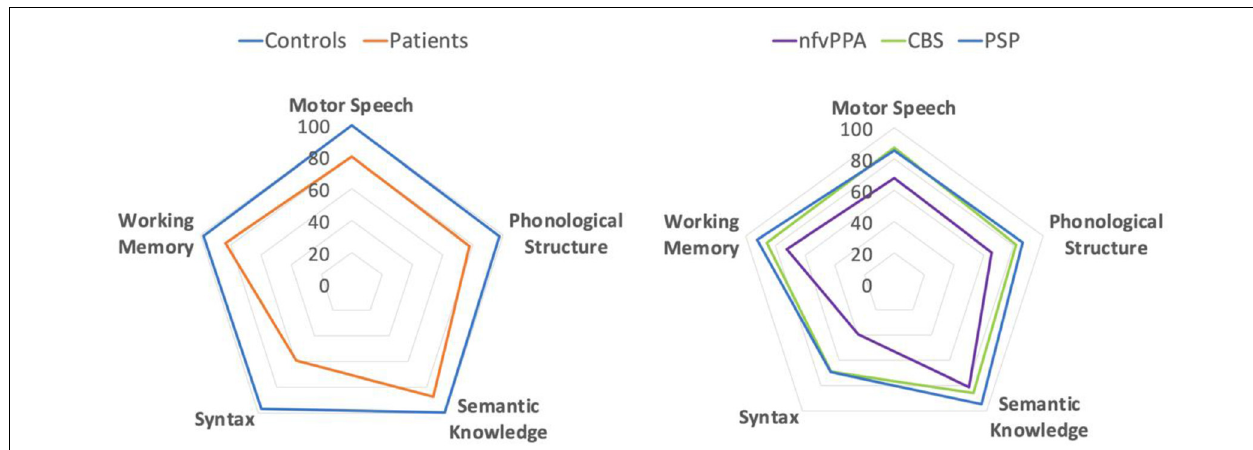
FIGURE 2 | Radar plots showing percentage scores for MLSE subdomains.